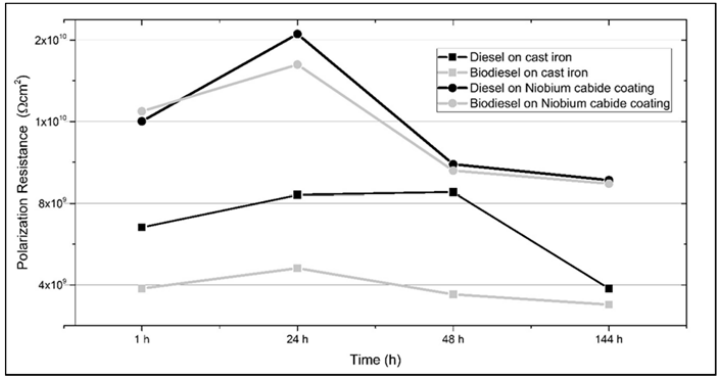
Figure 12. Polarization resistance obtained from the Nyquist diagrams via EIS on the cast iron and niobium carbide coating in contact with the diesel and palm biodiesel at 291 ± 2 K.